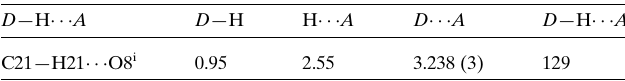
Table 1 Hydrogen-bond geometry (A˚ , (cid:3) ).